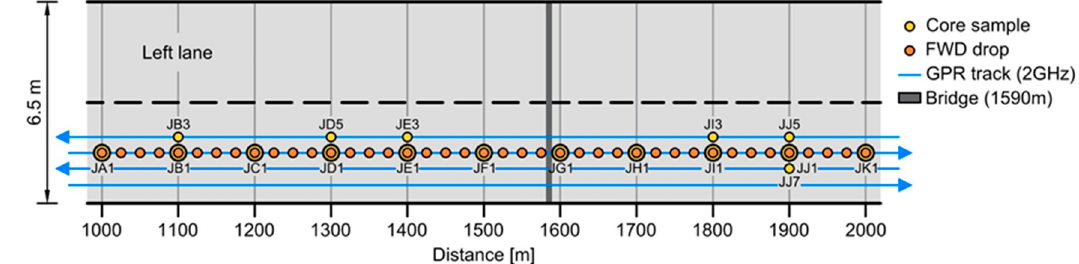
Figure 13. Spatial arrangement of the measurements of the experimental road section.